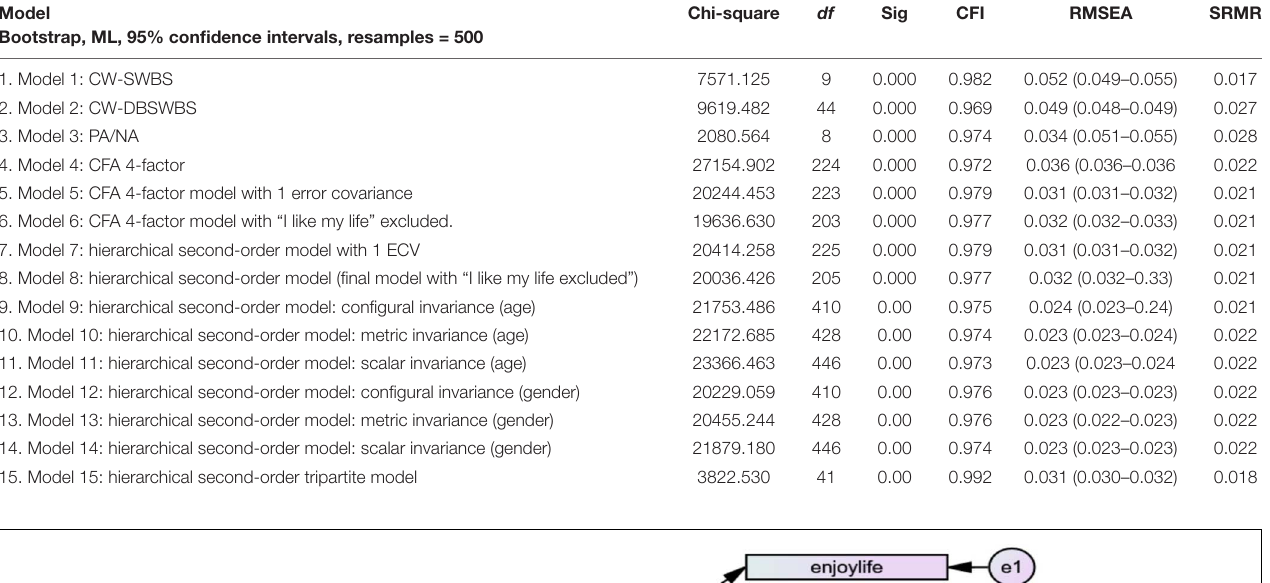
TABLE 3 | Fit indices for the confirmatory factor and structural equation models.